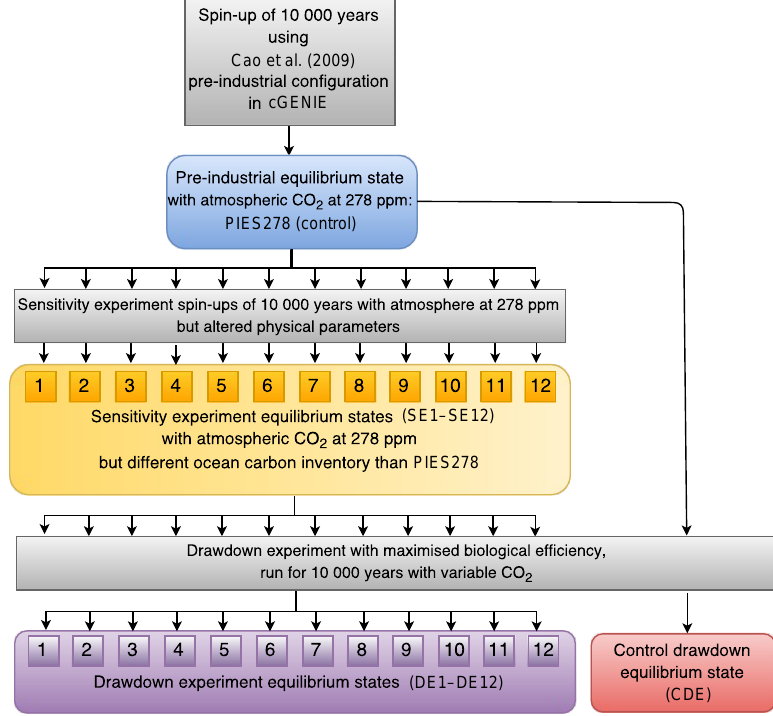
Figure 1. Flow chart showing the experimental set-up. Grey boxes are spin-ups and transient stages of simulations (not analysed). Coloured boxes are equilibrium states that are analysed in this study. Throughout the study, the pre-industrial equilibrium state PIES278 (light blue box) is used as the control state, with which we compare the sensitivity experiment equilibrium states SE1–SE12 (yellow box). The change in physical characteristics for each SE state compared to the control state PIES278 is described in Table 1. The SEs are then used as a basis for the CO 2 experiments in which biological efficiency is maximised. After running the drawdown experiments for 10000 model years, we achieve a new ensemble of drawdown equilibrium states (DE1–DE12) which are compared to a control drawdown equilibrium state